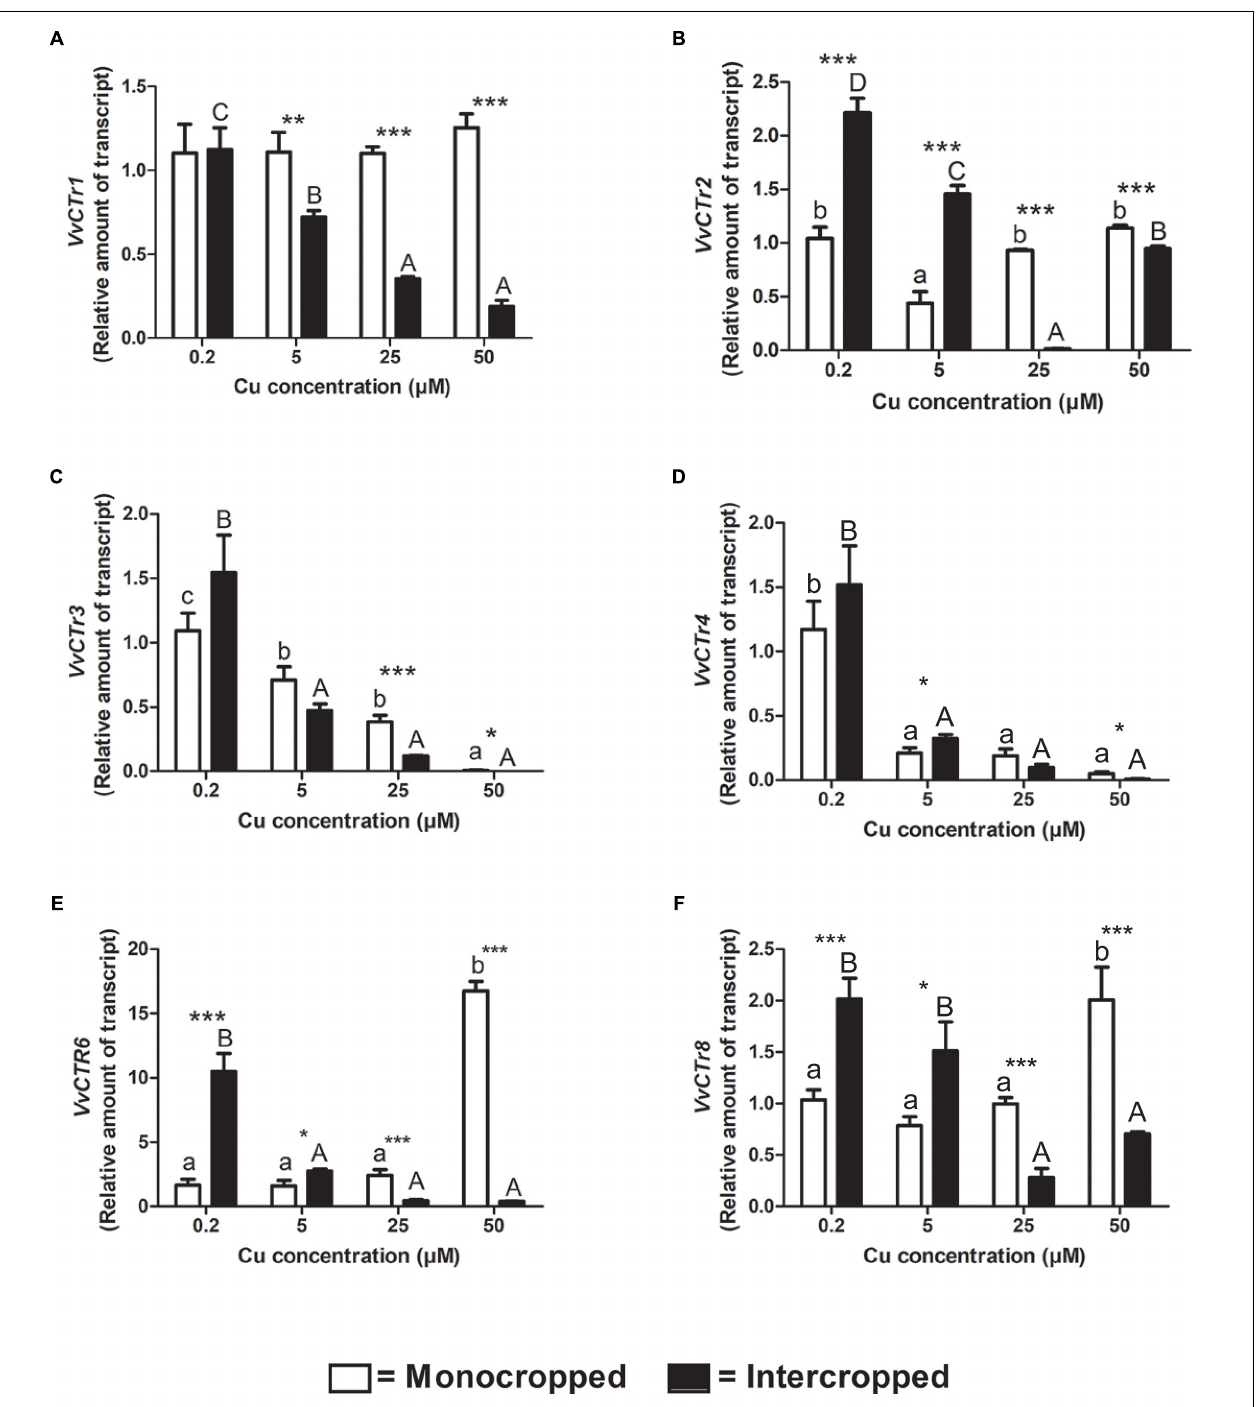
FIGURE 7 | Quantitative real time RT-PCR analyses of VvCTr genes in 196.17 rootstock plants. Root apex genes expression of VvCTr1 (A) , VvCTr2 (B) , VvCTr3 (C) , VvCTr4 (D) , VvCTr6 (E) , and VvCTr8 (F) determined in mono- and intercropped 196.17 rootstocks. Transcripts levels are reported as relative amount of transcripts referred to the gene expression of monocropped rootstock grown at 0.2 µ M Cu. The data are reported as means ± SE of three biological replicates. Different letters indicate significantly different values as determined using one-way ANOVA with Tukey post hoc tests ( p < 0.05). Lower case letters indicate the statistical significance for monocropped plants in the different Cu concentrations, whilst upper case letters indicate the statistical significance for intercropped plants grown in the different Cu concentrations. Stars indicate the significance (Student’s t -test) between the gene expression of mono- and intercropped rootstocks ( ∗ p < 0.05; ∗∗ p < 0.01; ∗∗∗ p <